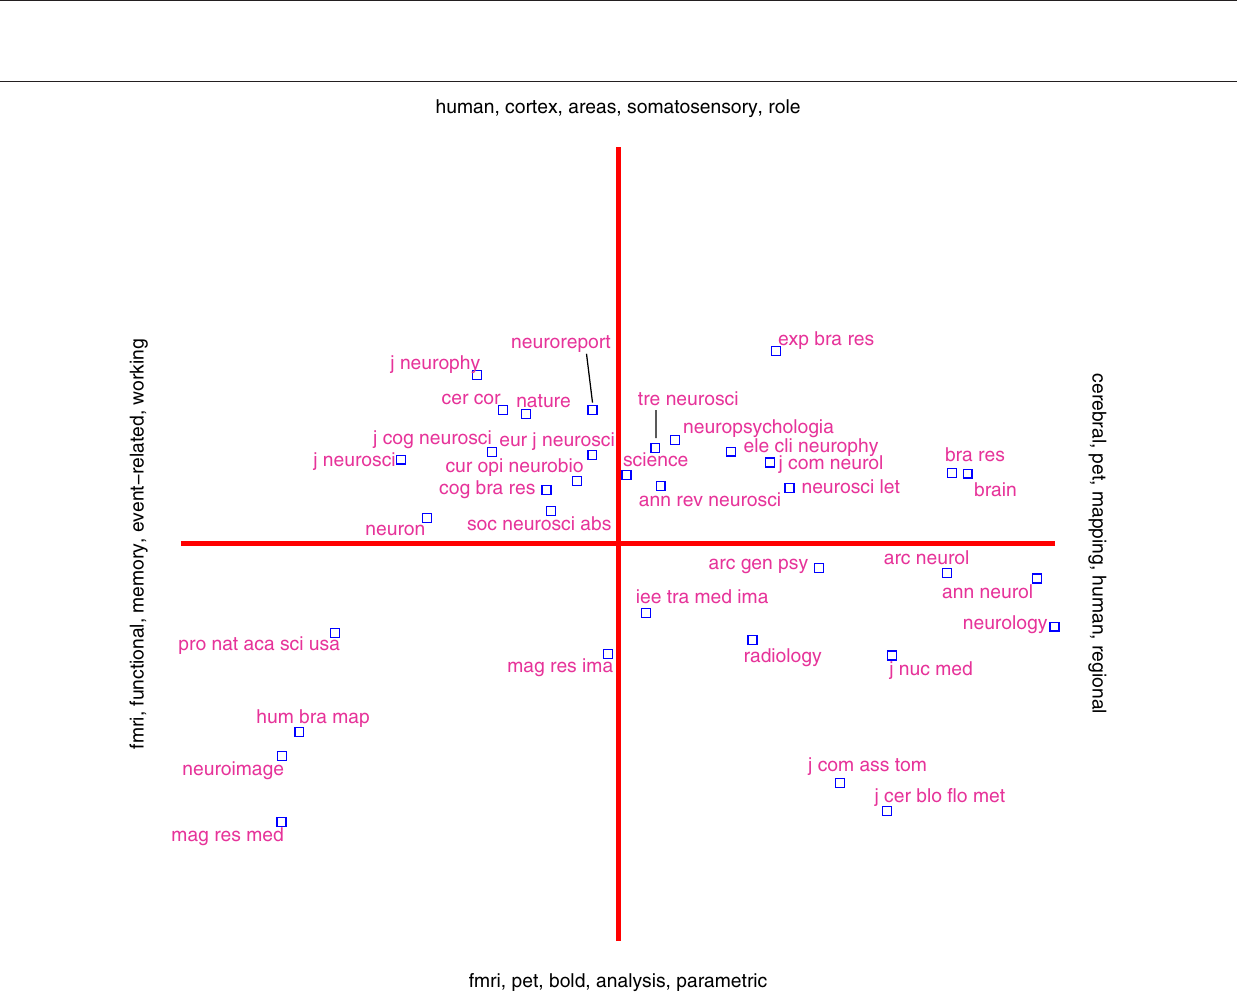
FIGURE 10 | A ‘functional’ atlas generated from a combined data mining of text and brain coordinates from the Brede Database. (A) Corner cube visualization with labeled brain areas. (B) Automatically generated legend with words from the text mining of abstracts.